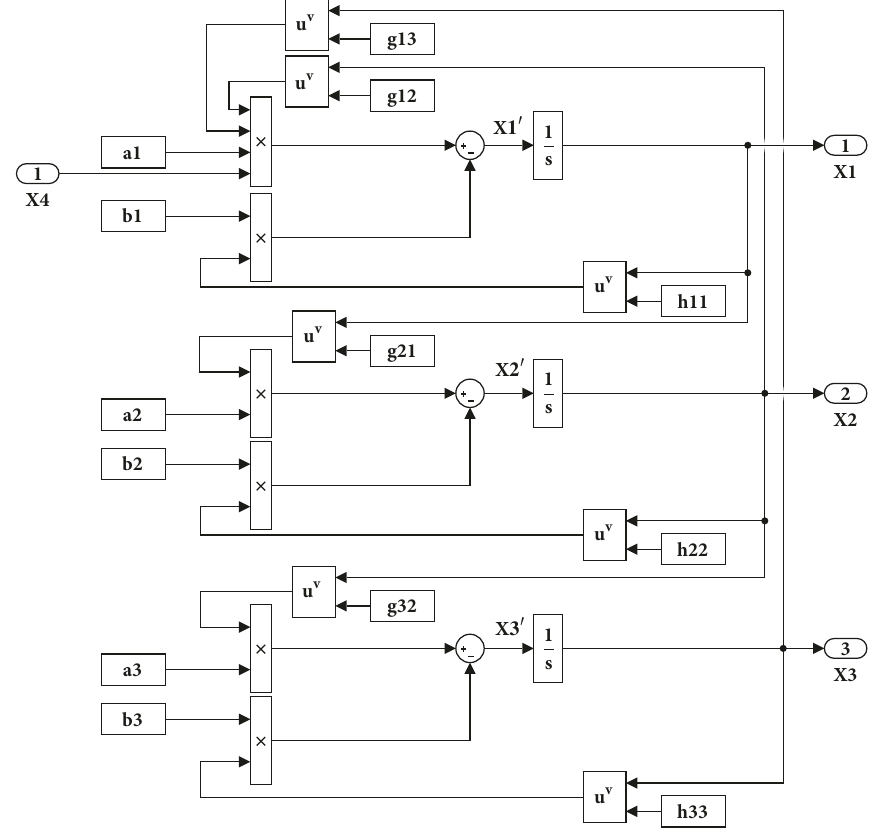
Figure 2: The block diagrams for the cascade pathway.